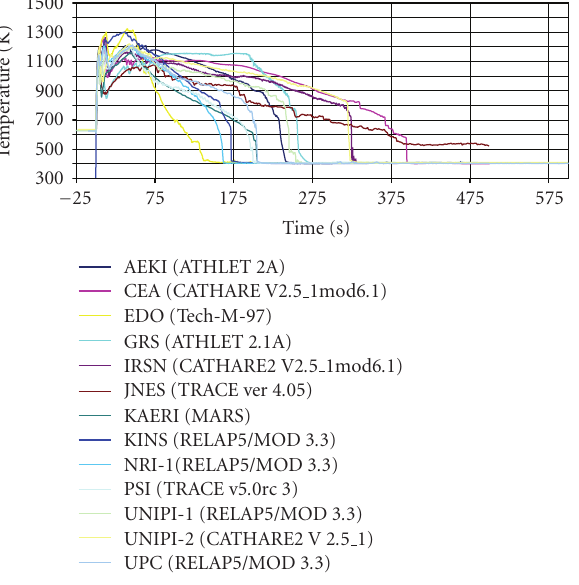
Figure 10: Time trends of maximum cladding temperature.